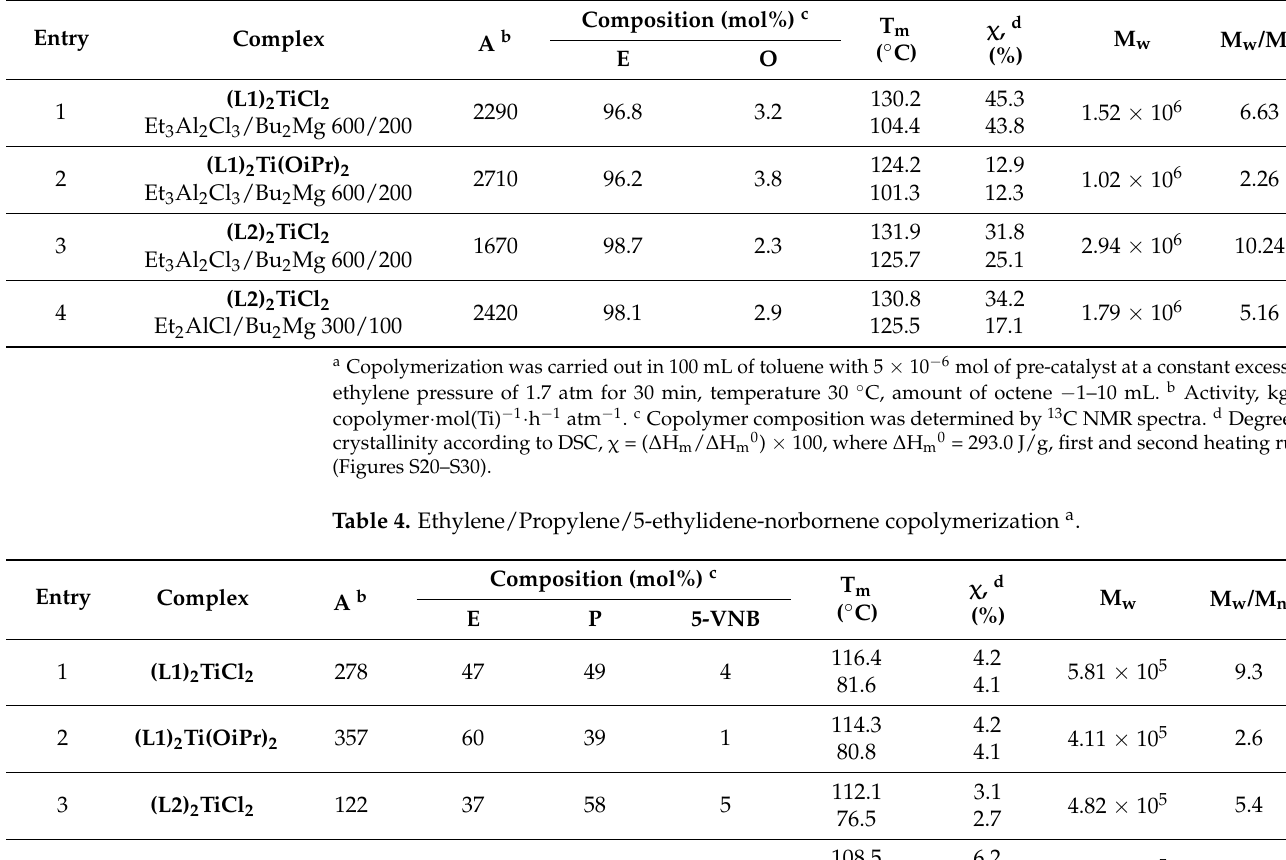
Table 3. Ethylene/1-Octene copolymerization a .